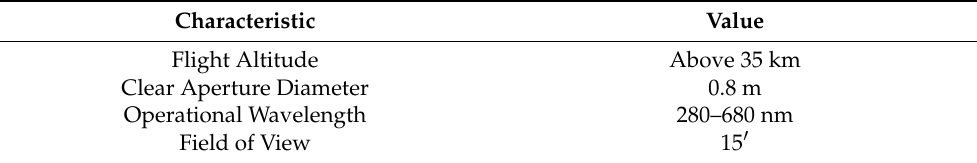
Table 1. Summary of Planetary Atmosphere Spectroscopic Telescope (PAST) parameters.